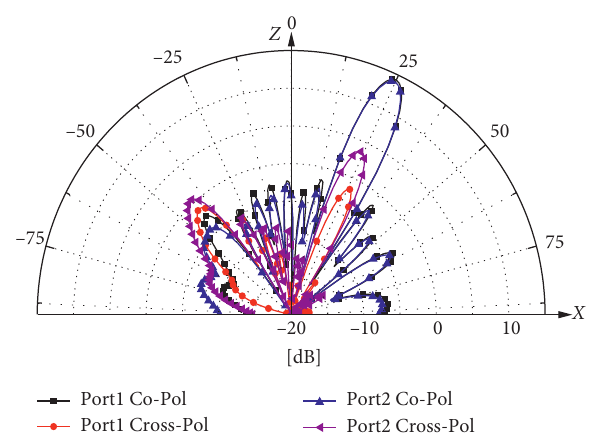
Figure 9: Simulated radiation pattern with the beam steering angles of θ xoz � 25 ° .